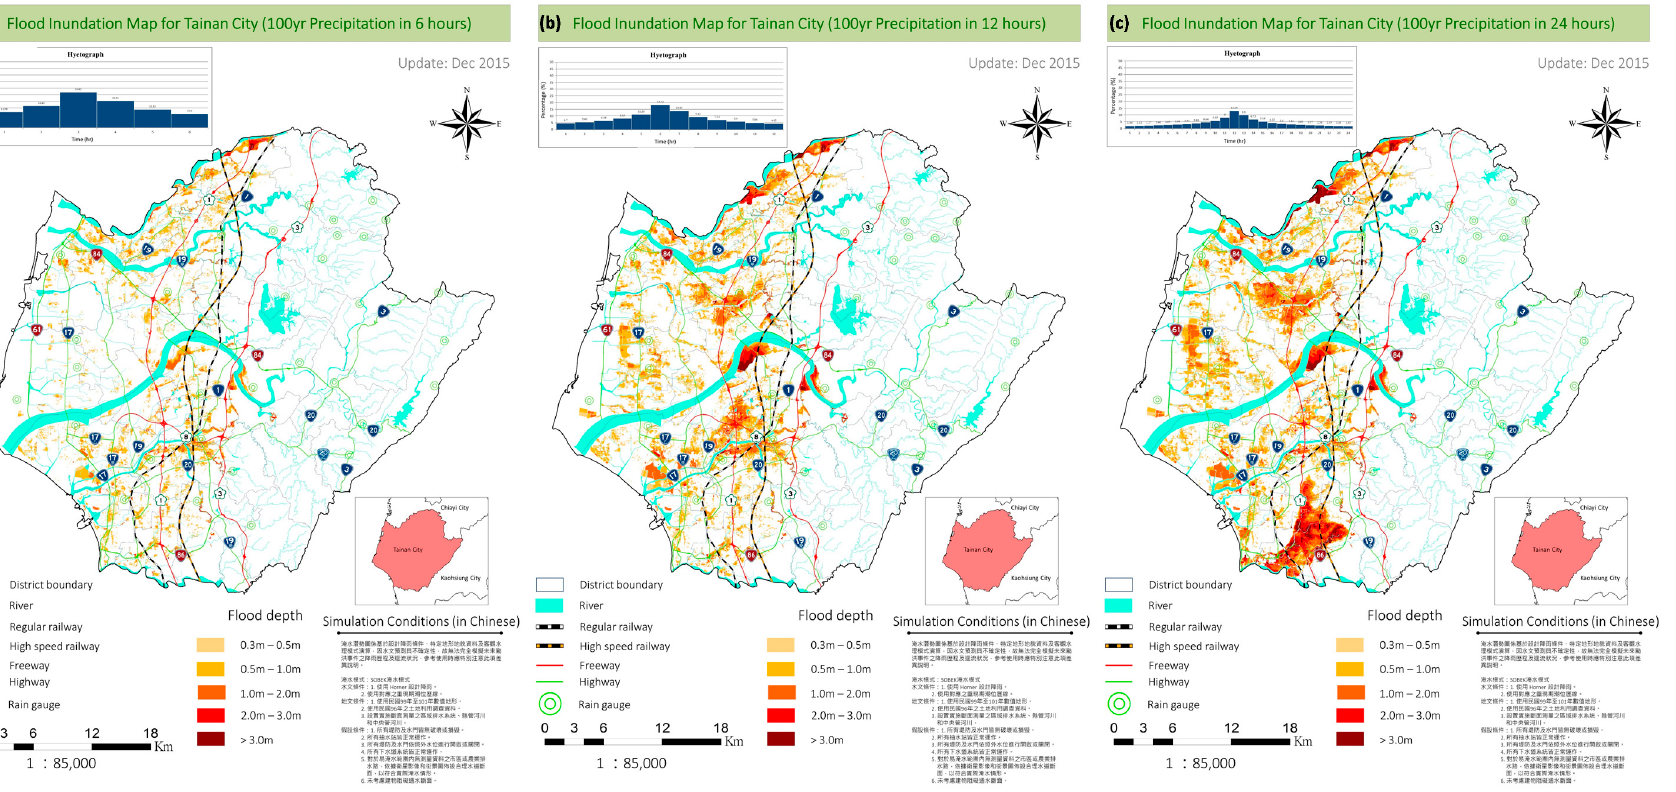
Figure 13. Productions of flood inundation map for Tainan City under conditions: ( a ) 100 ‐ year rainfall for 6 h (PR ‐ 6 ‐ 100); ( b ) 100 ‐ year rainfall for 12 h (PR ‐ 12 ‐ 100); and ( c ) 100 ‐ year rainfall for 24 h (PR ‐ 24 ‐ 100).